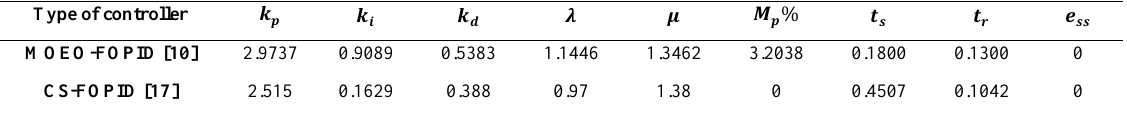
Table 3. Comparative performance of the controllers.